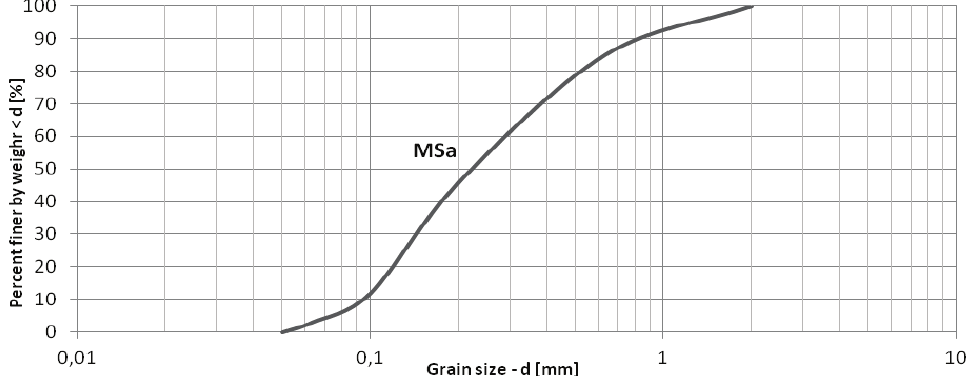
Fig. 1. Particle size distribution of test